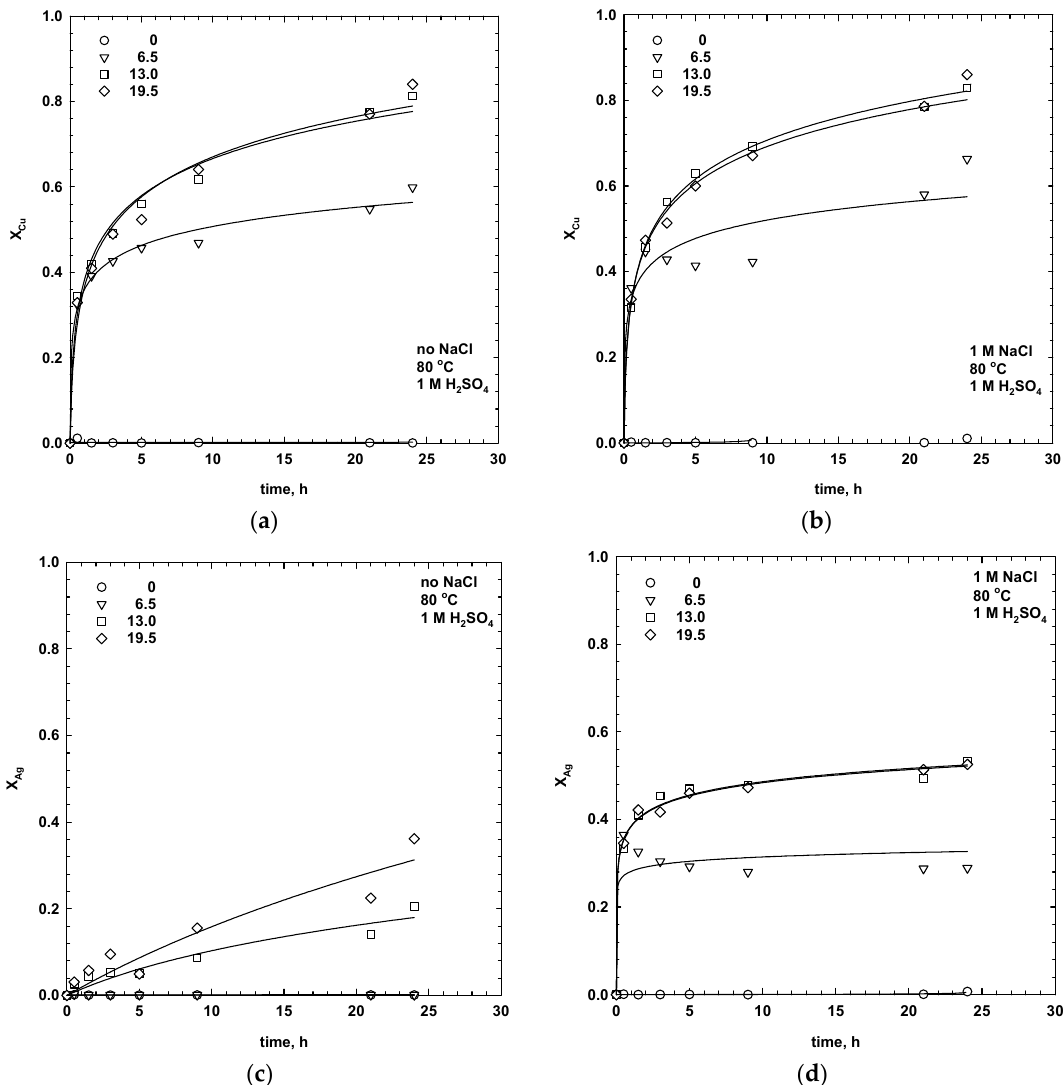
Figure 2. Effect of MnO 2 dosage (g/dm 3 ) on the dissolution (X) of copper ( a , b ) and silver ( c , d ) in the absence ( a , c ) and presence ( b , d ) of chloride ions (80 °C, 1 M H 2 SO 4 , 30 g/dm 3 SMS, 300 rpm).